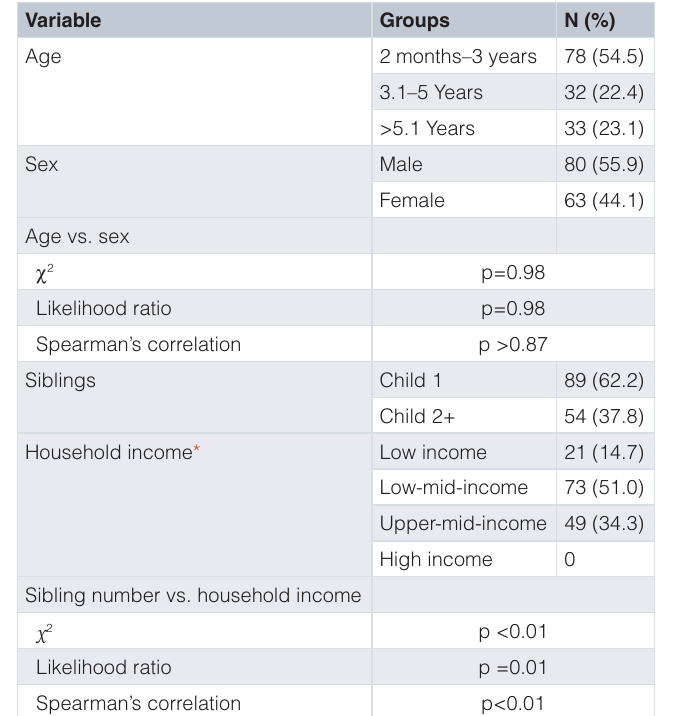
Table 1. Socio-demographic characteristics and household income of child’s family attending the Pabna Medical College and General Hospital with the complaints of hand, foot and mouth disease (n=143